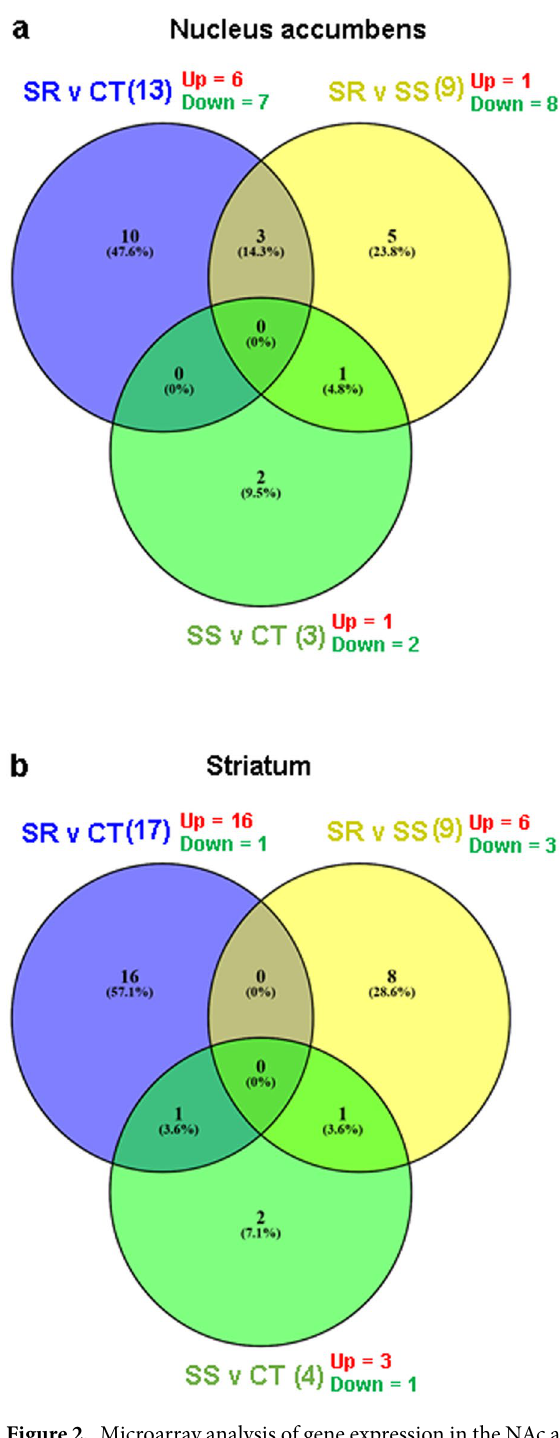
Figure 2. Microarray analysis of gene expression in the NAc and dorsal striatum of rats after one month of withdrawal from methamphetamine SA. Comparison of gene expression in pairwise comparisons between SR, SS, and control rats in NAc ( a ) in dorsal striatum ( b ) [n = 6 in each group]. The number of up- and downregulated genes in each comparison is shown in red and green, respectively. The list of genes and their classification are shown in Tables 1 and